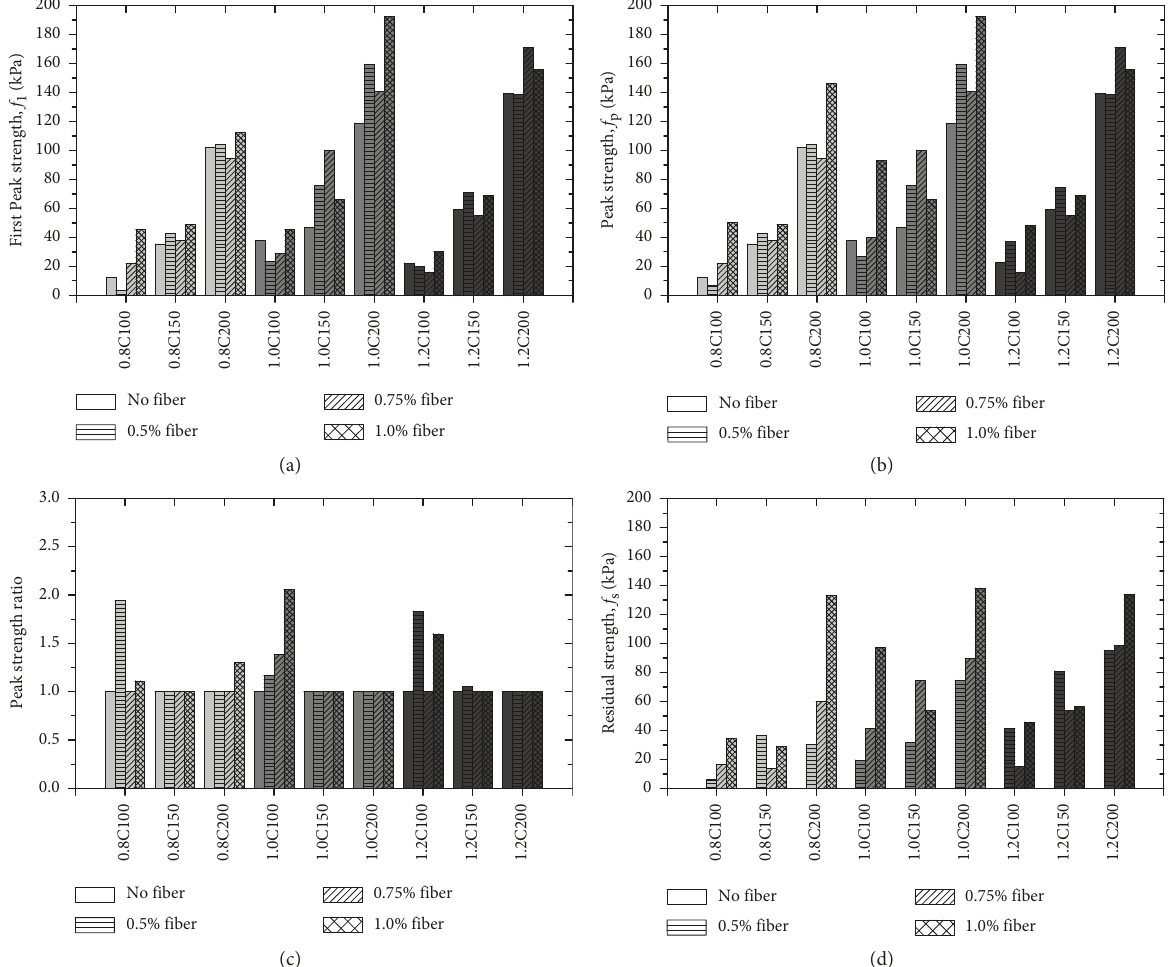
Figure 6: Effect of fiber content on the flexural performance of LFS: (a) first peak strength; (b) peak strength; (c) peak strength ratio; (d) residual flexural